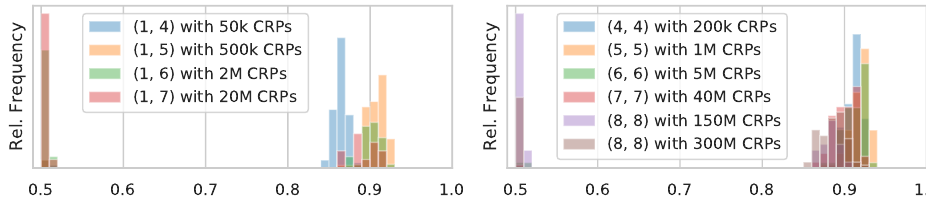
Figure 2: Accuracy of the lower layer model ˆ f d after training using the CRP set ( C d , R ) with randomly guessed interpose bits for (1 , k ) and ( k, k )-Interpose PUFs, as captured after execution of line 3 of Alg. 2. Results shown are using the estimated best number of challenge-response pairs (see also Table 1); accuracy is relative to the PUF simulation’s reliability. As with ordinary learning of XOR Arbiter PUFs, the probability to obtain a high-accuracy model of the lower layer depends on the size of the Interpose PUF and the training set size. (Just for completeness, our results are artificially capped at 95% due to termination-criteria of the algorithm which increase performance. For models where the initial modeling resulted in the model for a half-inverted lower layer, the accuracy on this is shown; for a justification see Sec.